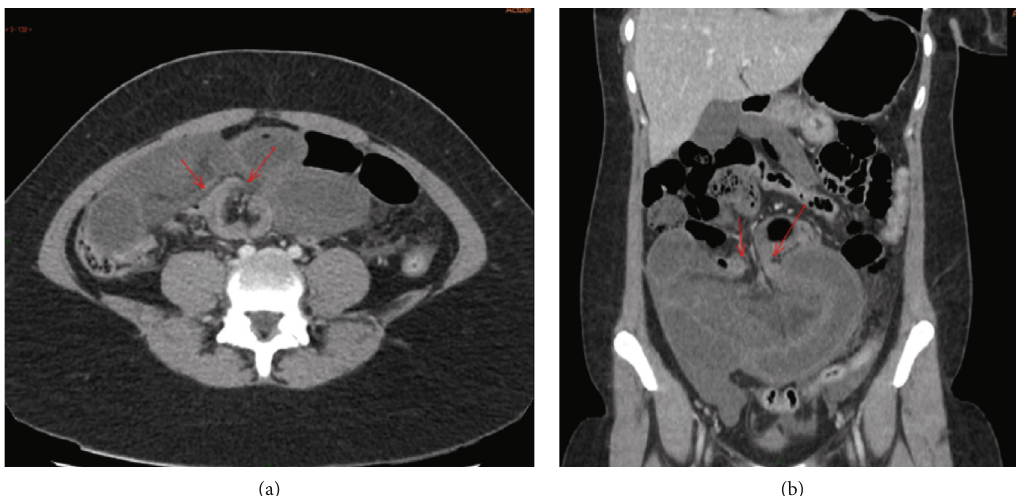
Figure 1: Abdominal CT scan injected in the late phase, showing a fl uid dilation of the small intestine and a short junction syndrome in the periumbilical area with no image of “ small bowel feces ” upstream, re fl ecting a volvulus, with thick and poorly enhanced digestive walls: (a) axial section; (b) frontal reconstruction.